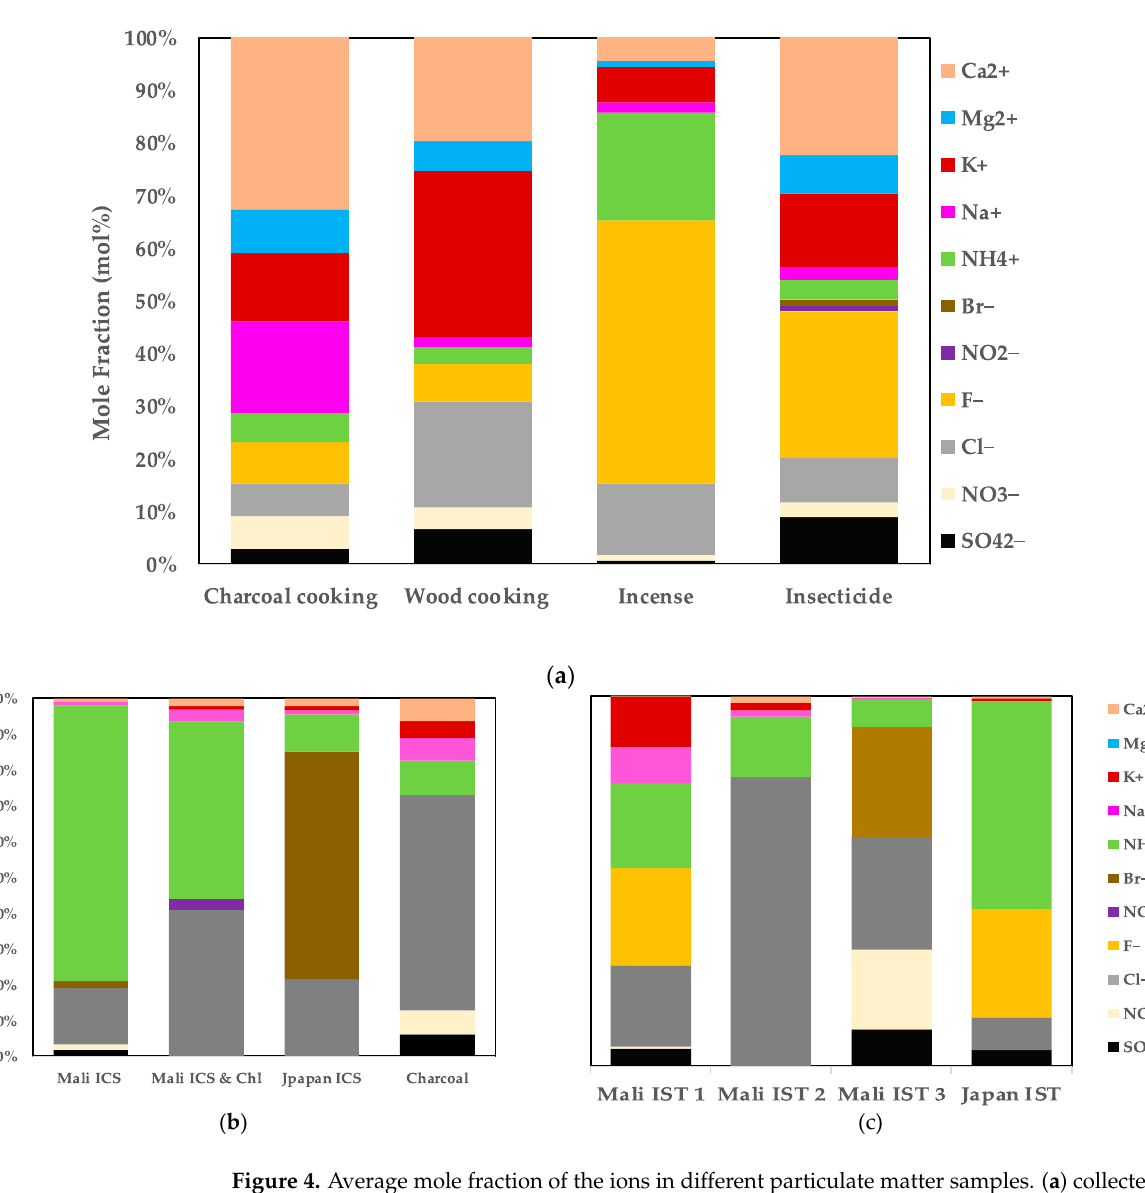
Figure 4. Average mole fraction of the ions in different particulate matter samples. ( a ) collected by in situ samplings; N = 18, ( b ) and ( c ) comparison of mole fraction of the ions in different PM samples collected in the laboratory; N = 22. Mali ICS: incense in Mali; Mali ICS & Chl: incense in Mali mixed with Charcoal; Japan ICS: incense in Japan; Mali ICS 1, 2 and 3: insecticide in Mali (different brands); Japan IST: insecticide in Japan.